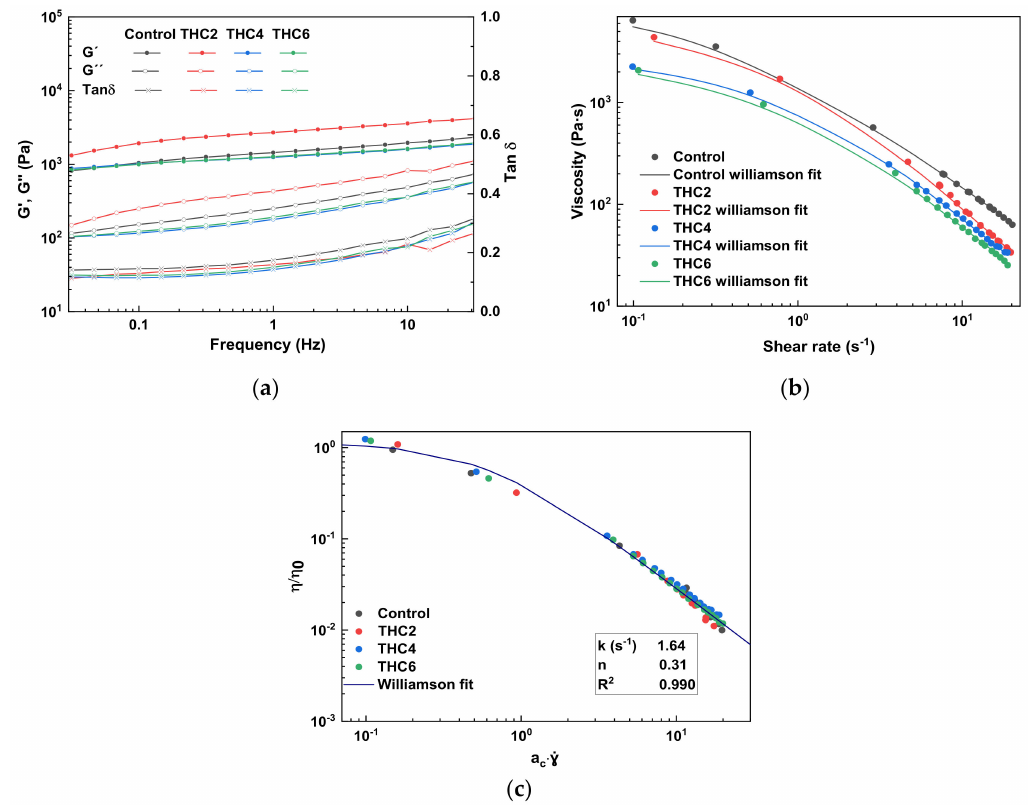
Figure 1. ( a ) Storage moduli (G ´ ), loss moduli (G”), and loss tangent (tan δ ), obtained through frequency sweep test for collagen doughs; ( b ) Flow curves of collagen doughs, fitted by Williamson model; and ( c ) Master flow curve for collagen doughs fitted by Williamson model, after performing a THC concentration-dependent shift ( η 0 , a c ) using the control sample as